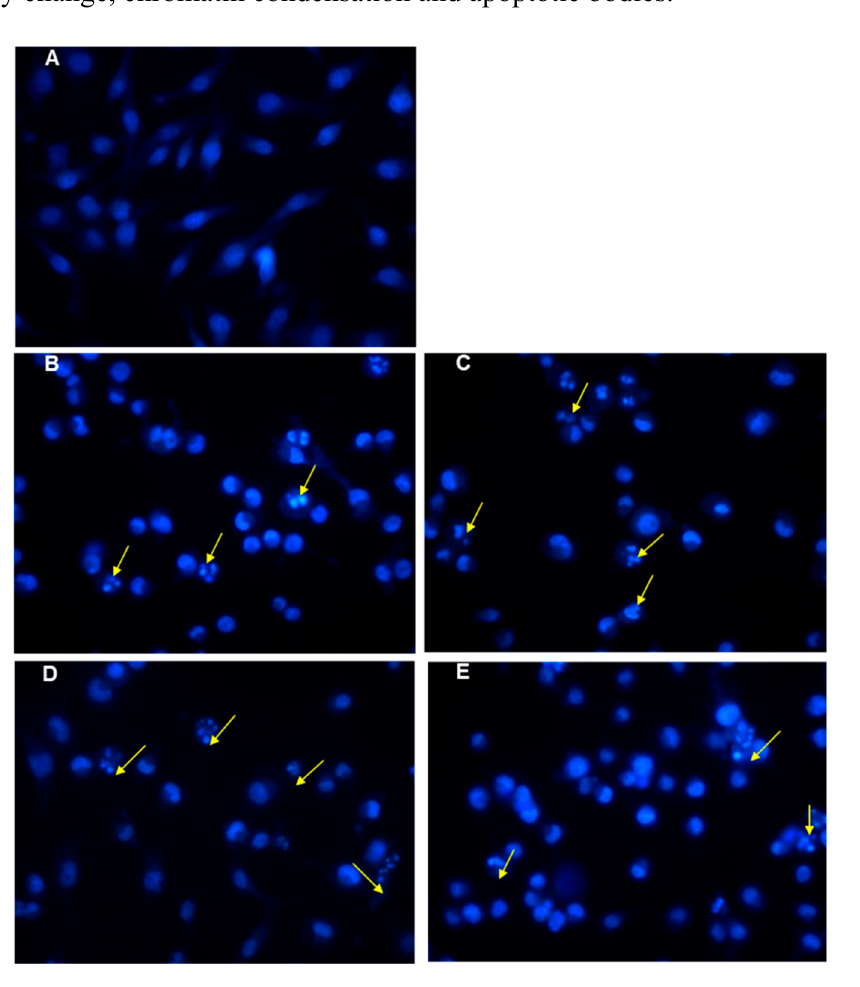
Figure 3. Detection of apoptosis in MDA-MB-231 cells by Hochest-staining. Treated cells were stained with Hoechst 33342, and then observed under a fluorescent microscope (magnification of ×400). ( A ) Sovent control treated MDA-MB-231 cells; ( B – E ) OHR-1 for 12 h. The yellow arrows indicated classic apoptosis characteristics in cells with morphology change, chromatin condensation and apoptotic